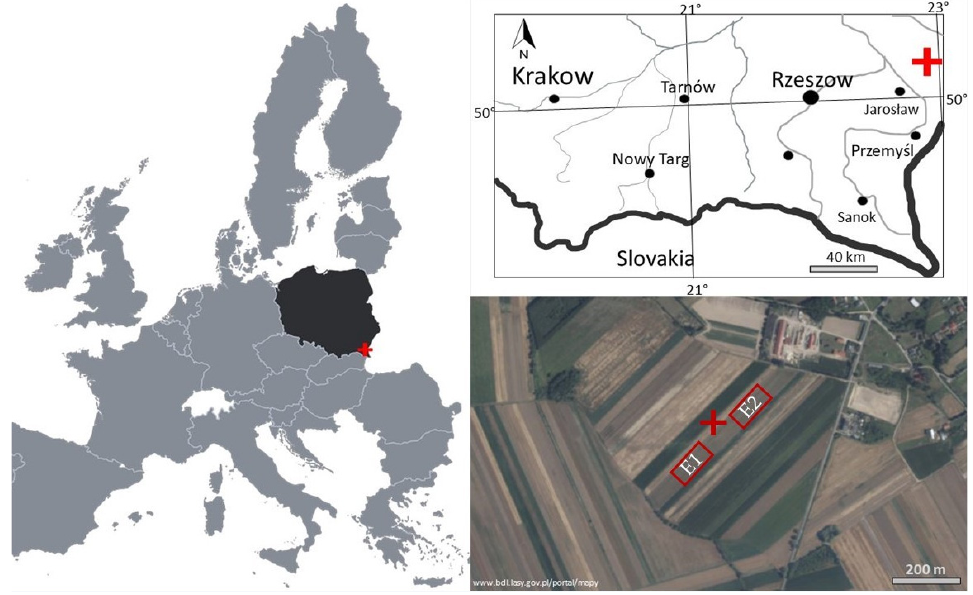
Figure 1. Location of the experimental field. E1—Gleyic Chernozem, E2—Haplic Luvisol [29].